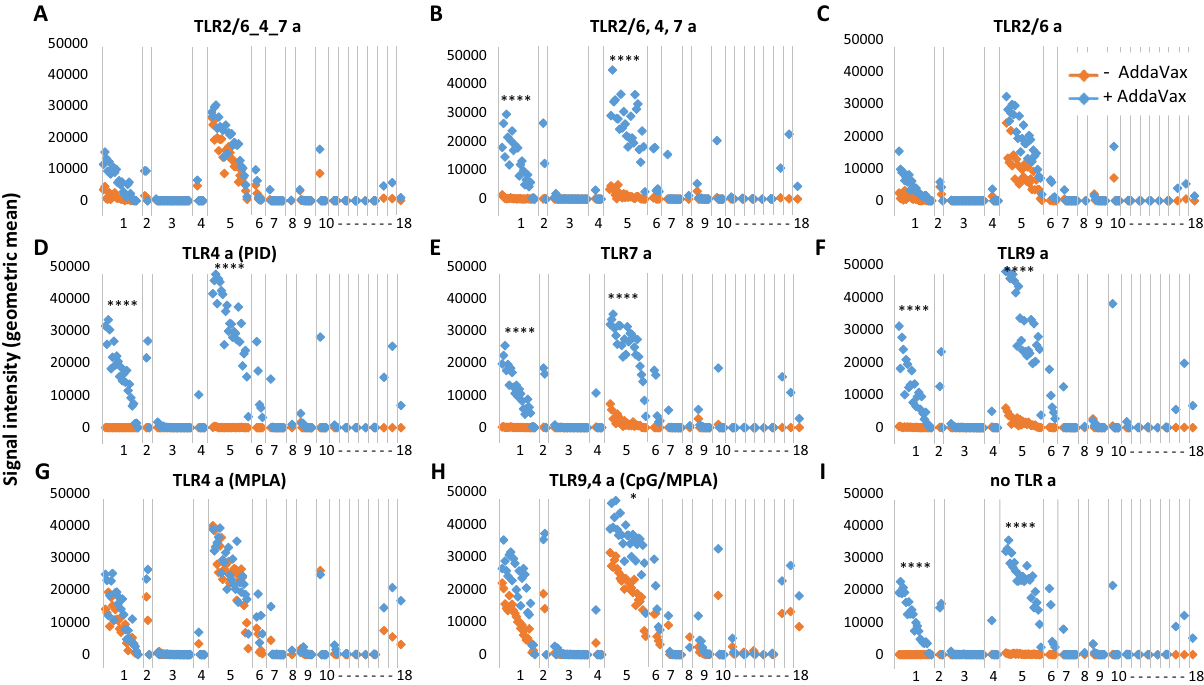
Figure 1. IgG profiles in response to trimerized influenza virus VN04 H5 vaccine formulated with different TLR agonists, with or without squalene oil-in-water emulsion (AddaVax). Antibody profiles were determined by probing immune plasma (d28-post vaccination) against HA protein microarray (Supplementary Table S1). Antigens (horizontal axis) are full-length (HA0) HA variants ranked within subtype H1-H18 by overall average of whole study population. Magnitude of response (vertical axis) are geometric means of each vaccine group (N = 4 mice). Breadth of response is summarized in Table 2. CpG cytosine-guanine oligo deoxynucleotide, AddaVax; MPLA monophosphoryl lipid A; PID pyrimido-indole derivative; TLRa TLR agonist. Kruskal Wallis Dunn’s multiple comparison between + and − AddaVax are indicated for H1 and H5; ****P < 0.0001; ***P ≤ 0.001; **P ≤ 0.01; *P <